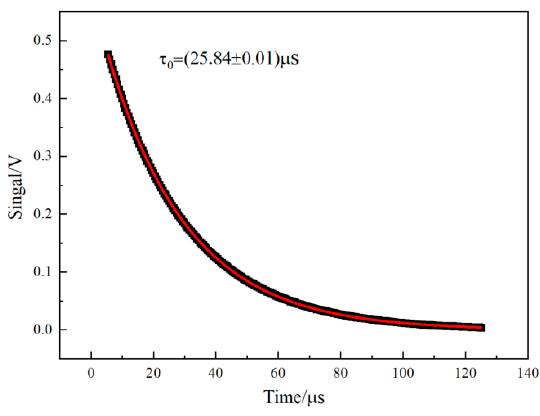
Figure 3. Cavity ring−down signal and fitting results.